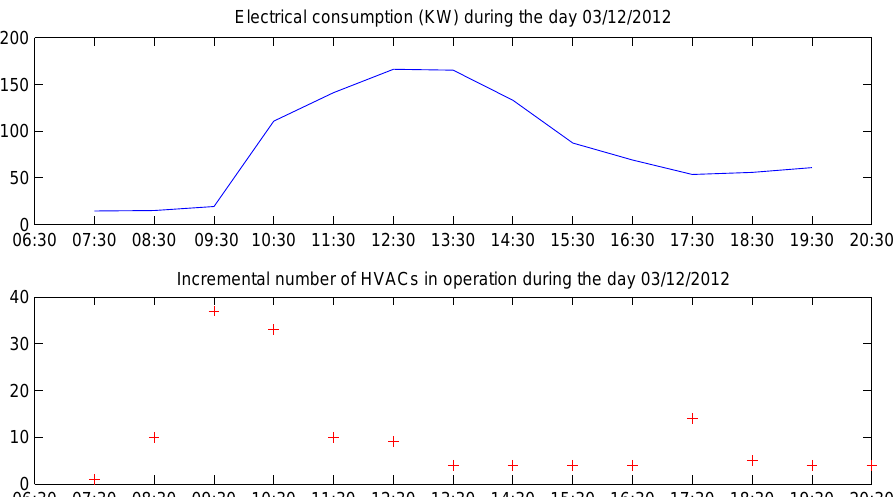
Figure 15. Evolution of the electrical power consumption and the incremental number of HVAC systems in